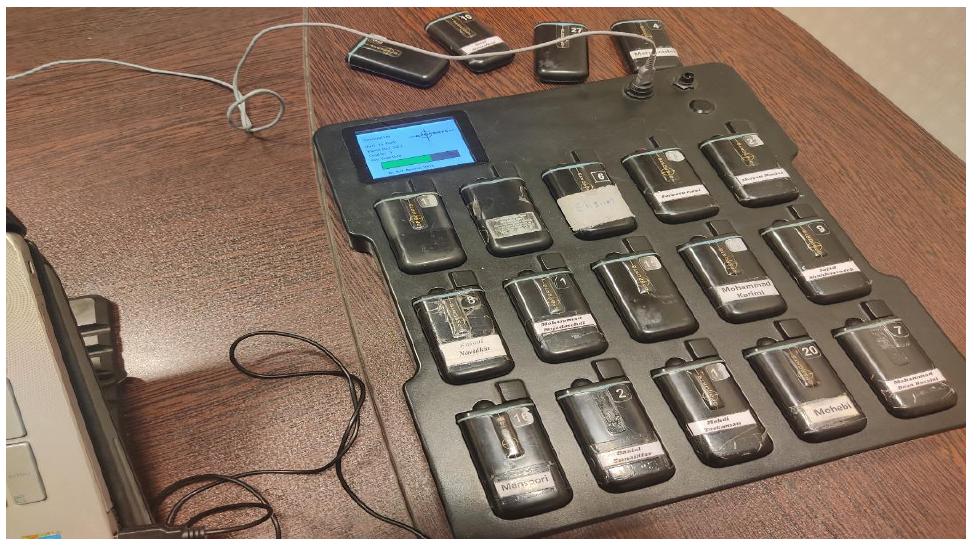
Figure 1. Tracking systems in GPS devices.